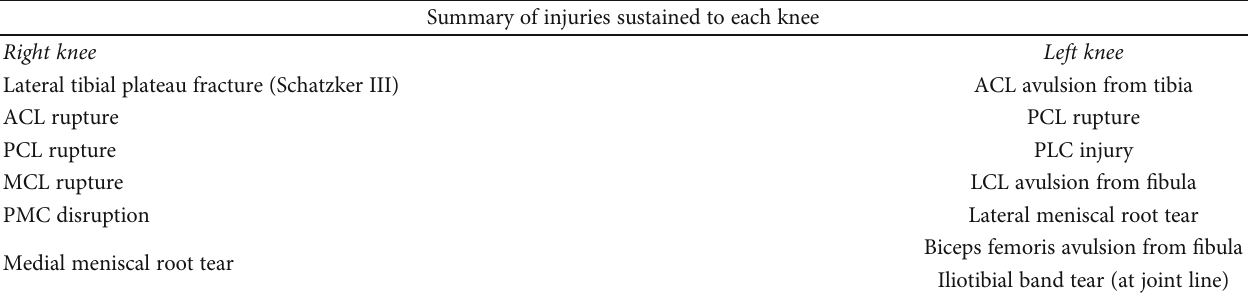
Table 1: List of injuries sustained.